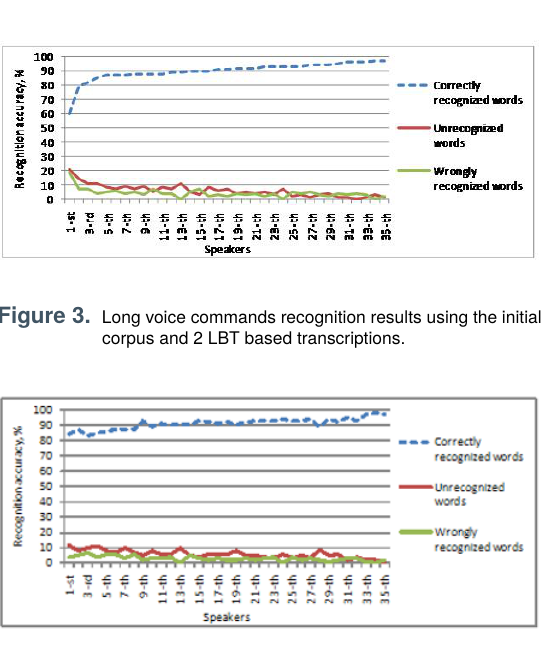
Figure 4. Long voice commands recognition results using the veri- fied corpus and 2 LBT based transcriptions.